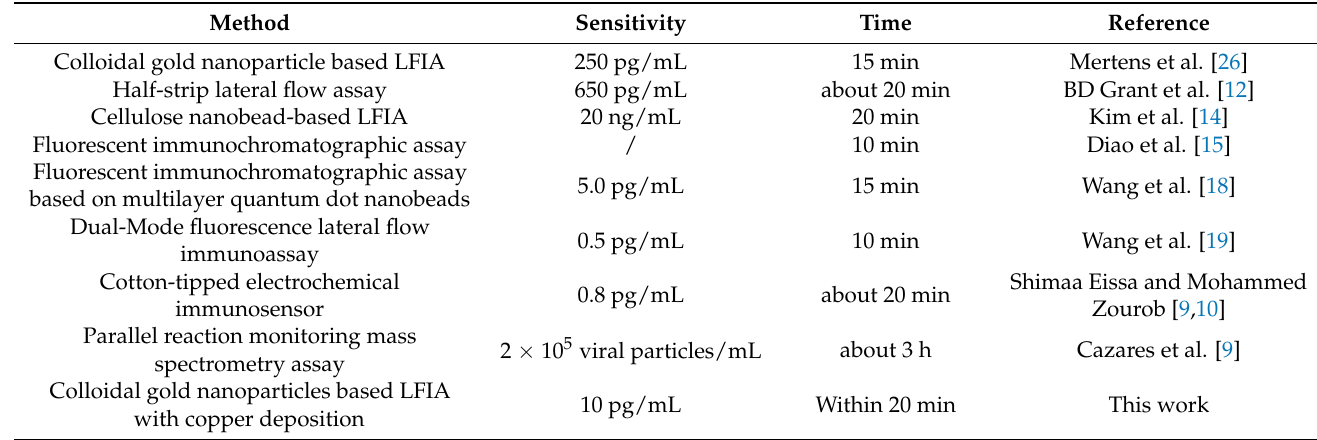
Table 1. Comparison of the performances among the developed method and other reported methods for SARS-CoV-2 NP antigen detection.